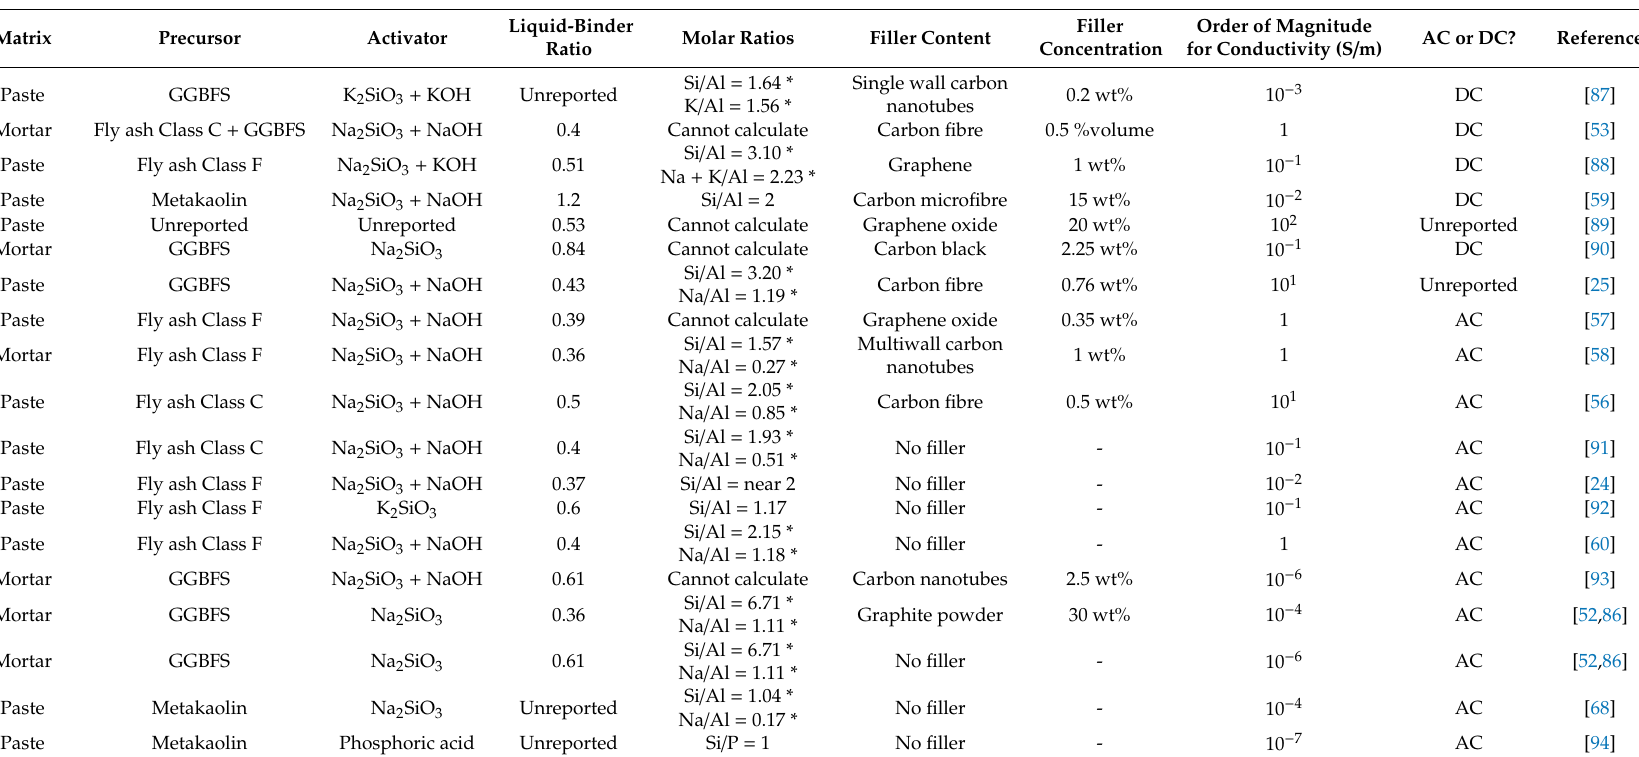
Table 1. Reported conductivity for AAM under ambient-near ambient conditions. Notations- sodium silicate (Na 2 SiO 3 ), sodium hydroxide (NaOH), potassium silicate (K 2 SiO 3 ), potassium hydroxide (KOH), silicon (Si), aluminium (Al), sodium (Na), potassium (K), Phosphorus